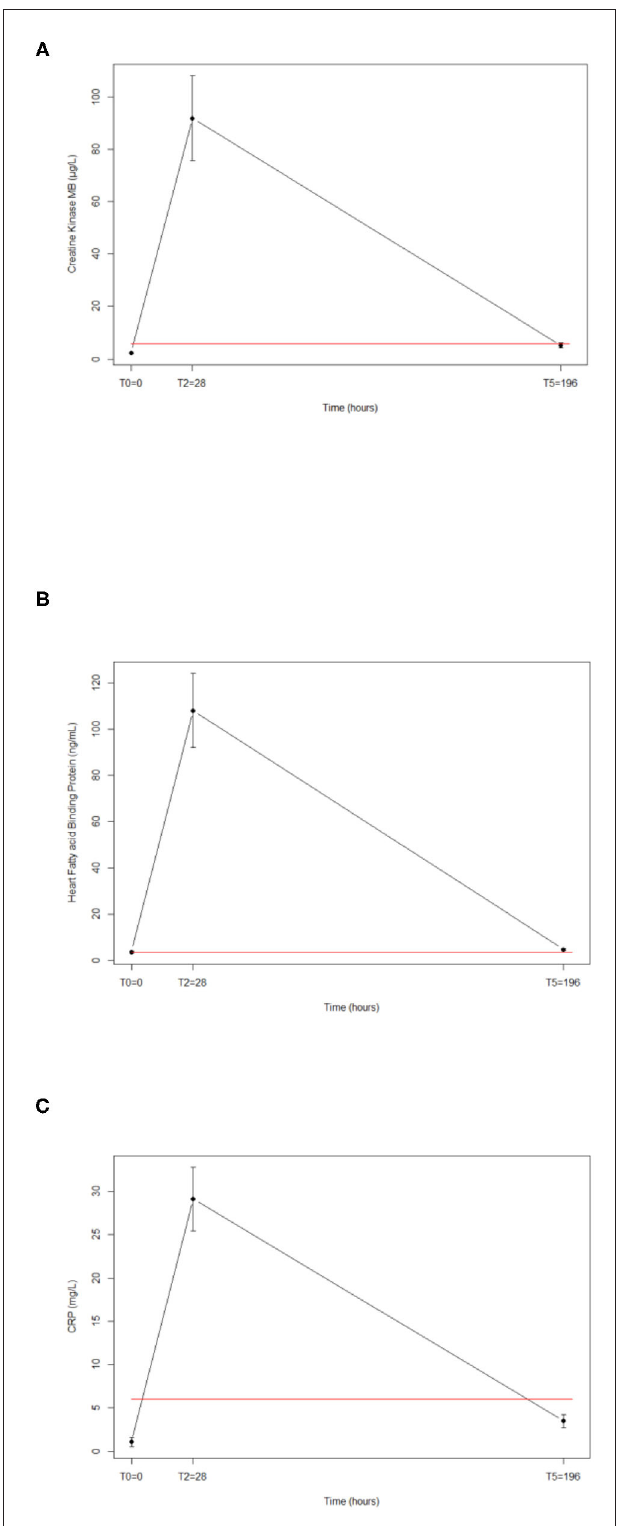
FIGURE 2 | Release of cardiac biomarkers induced by a 105-km (5600m of total elevation gain) run for CKMB (A) , HFABP (C) , and hsCRP (B) . Red line represents the cut-off